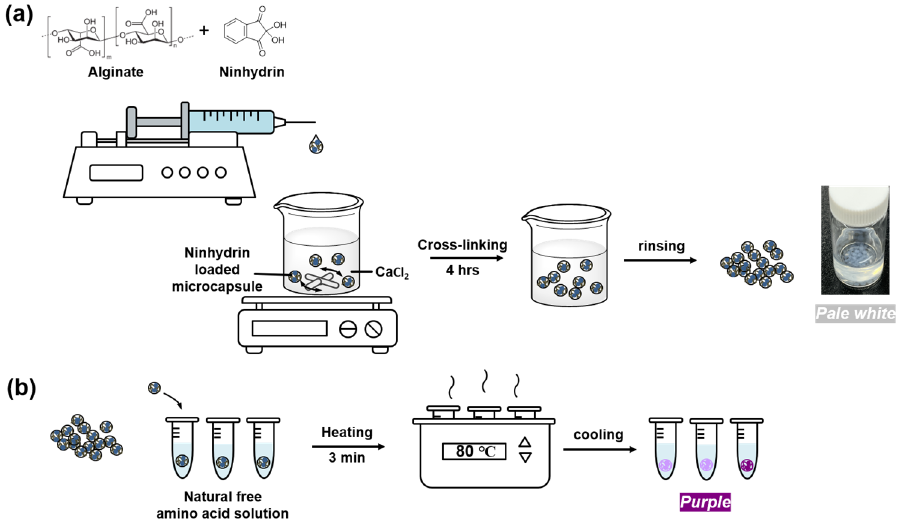
Figure 3. ( a ) Schematic illustration of ninhydrin-loaded microcapsule preparation. ( b ) The microcapsule-based colorimetric detection of natural free amino acid solution. Microcapsules were dipped into five different amino acid solutions. Figure 4 shows how the individual microcapsules appear purple inside the analyte solution and how the color was retained after the incubation. The trend in the degree of colorimetric change was aligned with the results obtained with the ninhydrin solution-based assay (Figure